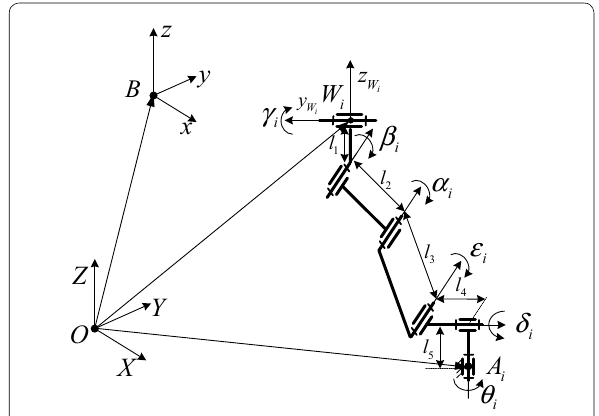
Figure 10 Mechanism of stance leg i